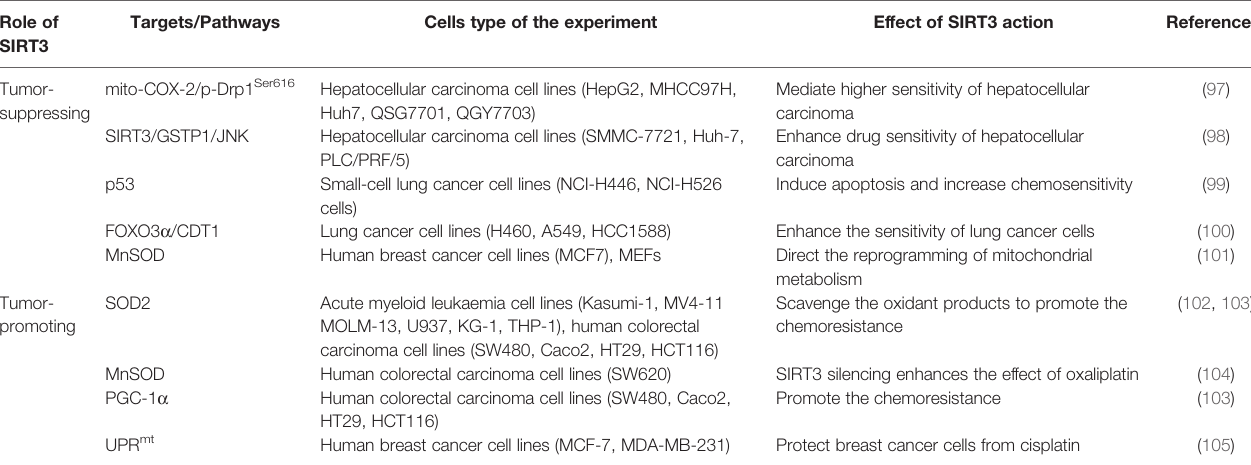
TABLE 3 | Regulation of cancer chemoresistance by